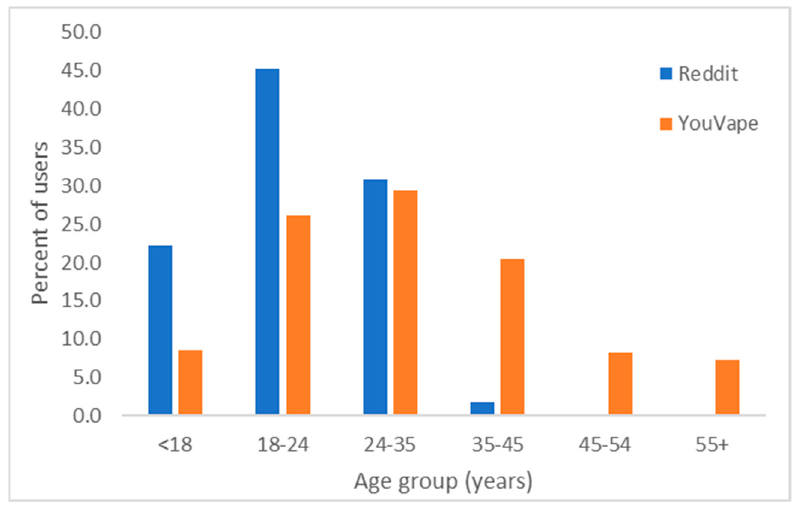
Figure 1. Age group distribution on Reddit and on YouVape.